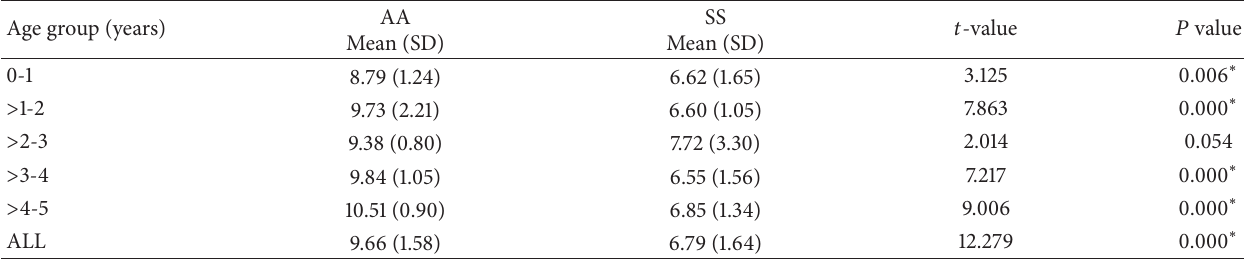
Table 5: Haemoglobin concentration distribution of study